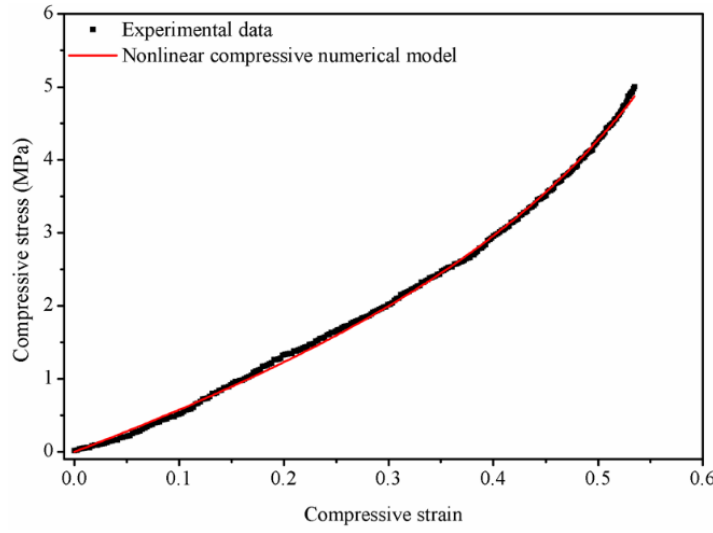
Figure 3. Compressive properties of a GDL with experimental and numerical results.